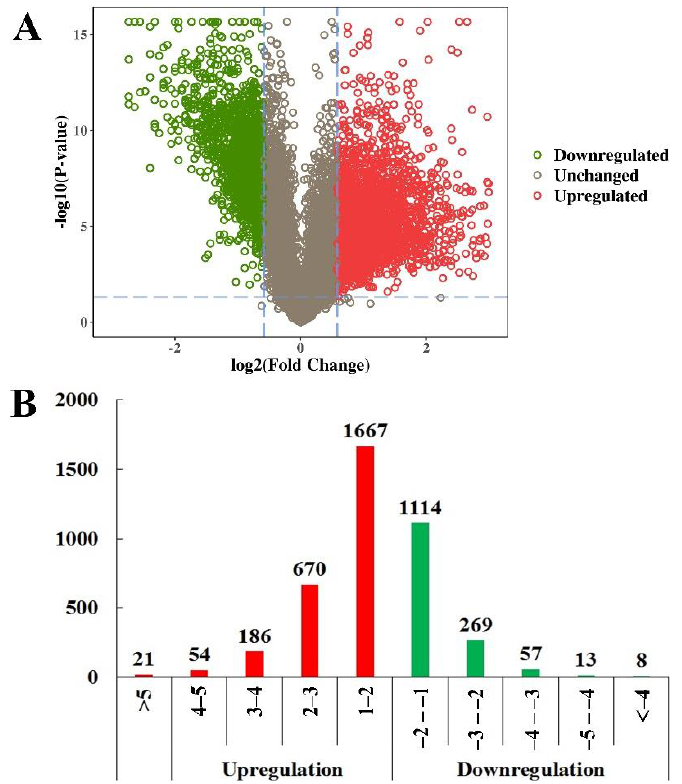
Figure 3. Quantitative analysis of characterized phosphopeptides. ( A ) Scatter plot of quantified phosphopeptides. The log 2 fold change value and −log 10 p value of phosphopeptides are indicated by the x -axis and the y -axis, respectively. The red circles and green circles denote upregulated and downregulated DEPs, respectively. ( B ) Distribution of upregulated DEPs and downregulated DEPs between the sporulated oocysts and tachyzoites on different levels. The x -axis and y -axis indicate the values of changes and the quantity of DEPs. The red color and green color represent upregulated DEPs and downregulated DEPs, respectively.